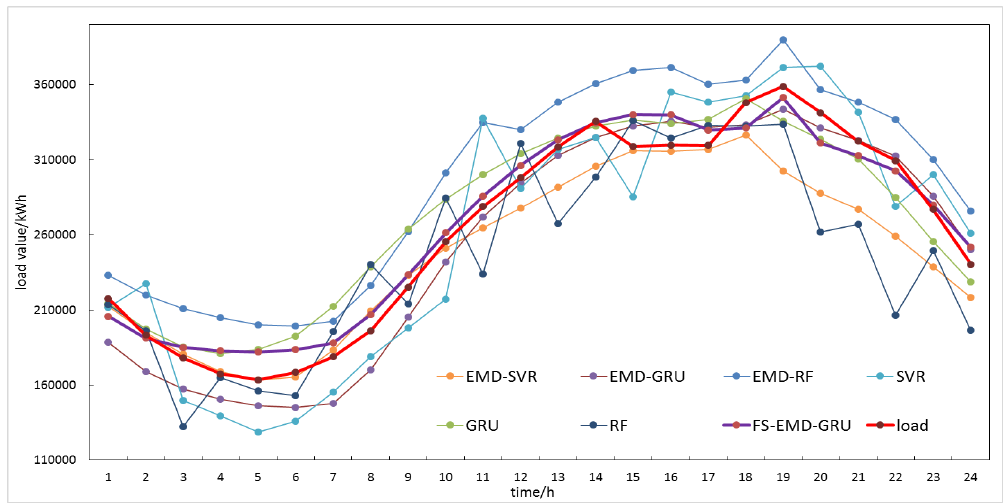
Figure 10. Comparisons of load forecasting results for a certain day in July 2006 of M_2 dataset.